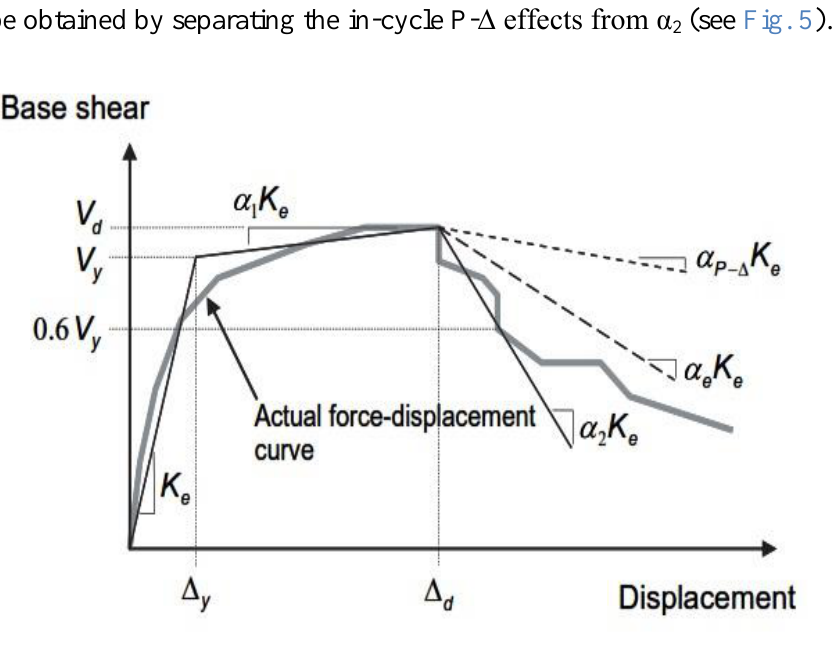
Fig. 6. Idealized Force-Displacement